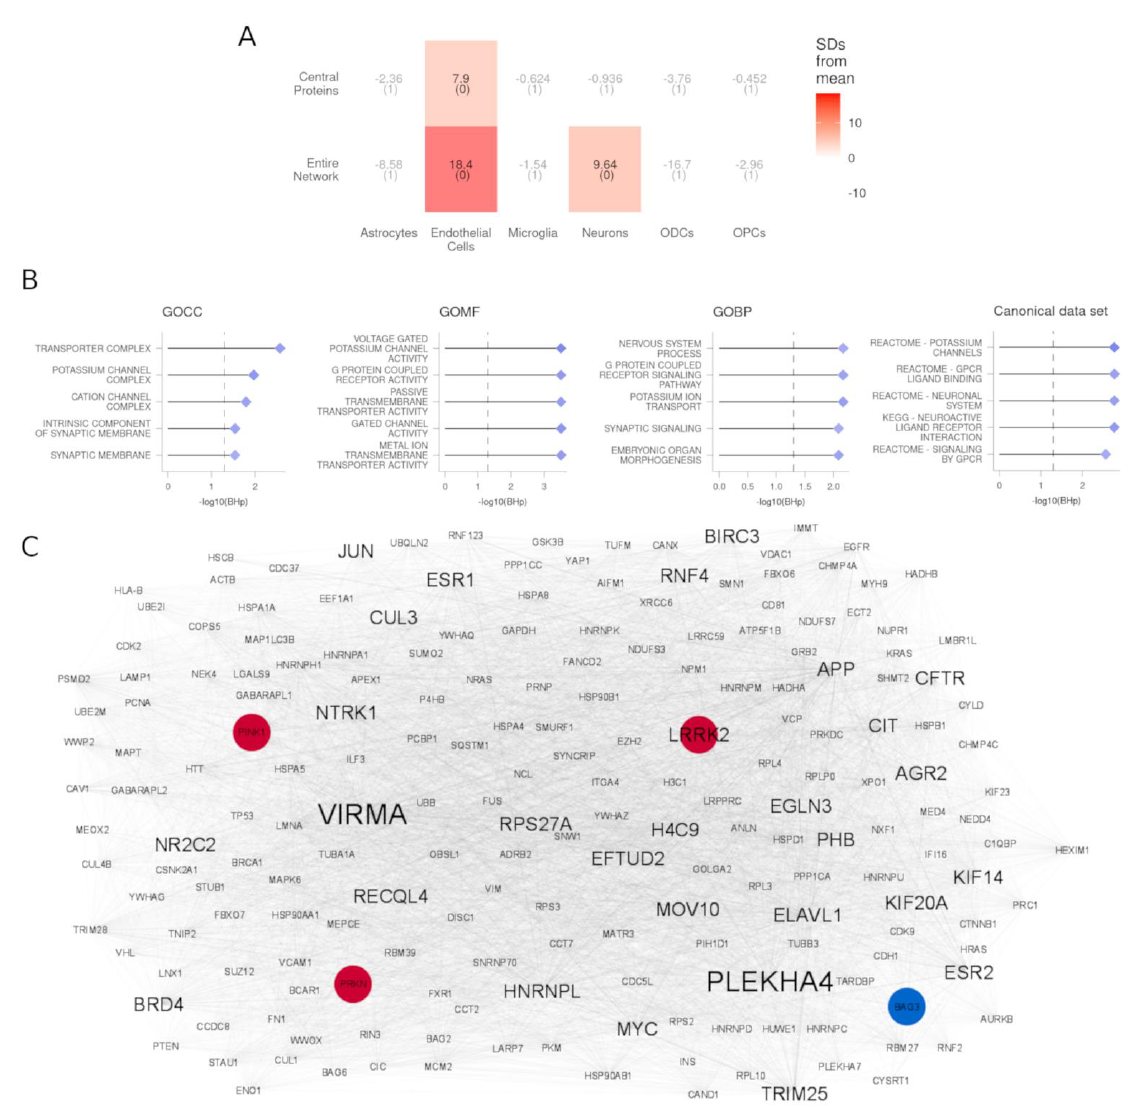
Figure 4. PPI network analyses. ( A ) EWCE results for the full network and central protein. The number of standard deviations of the expression of each list from the mean level expression of 10,000 equally sized random lists is reported for each cell type. BH – corrected p – values are reported between brackets. ( B ) GSEA results of the nodes in the network ranked by betweenness centrality. The – log 10 value of the adjusted p – value is reported on the x – axis, and the significance threshold (BHp = 0.05) is indicated by the dashed vertical line. ( C ) Network of the central proteins extracted from the full PPI network. Label size is proportional to the protein degree, edge thickness, and color proportional to the edge betweenness. PD – causing genes ( LRRK2 , PINK1 , PRKN ) and the genes closest to a risk factor ( BAG3 ) are highlighted in brick red and cerulean blue, respectively.